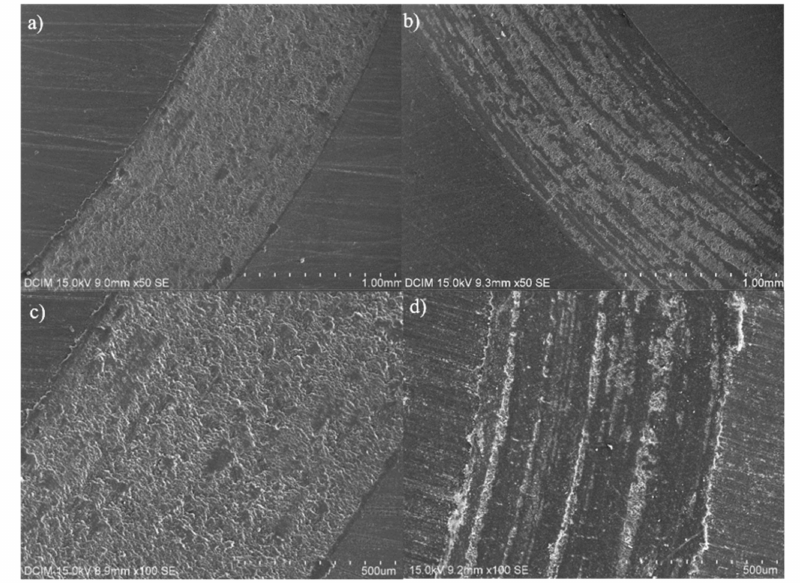
Figure 6. SEM images of worn surfaces of neat epoxy ( a , c ) and 2 wt.% of non-functionalised GNPs ( b ) and 2 wt.% amino functionalised GNPs ( d )